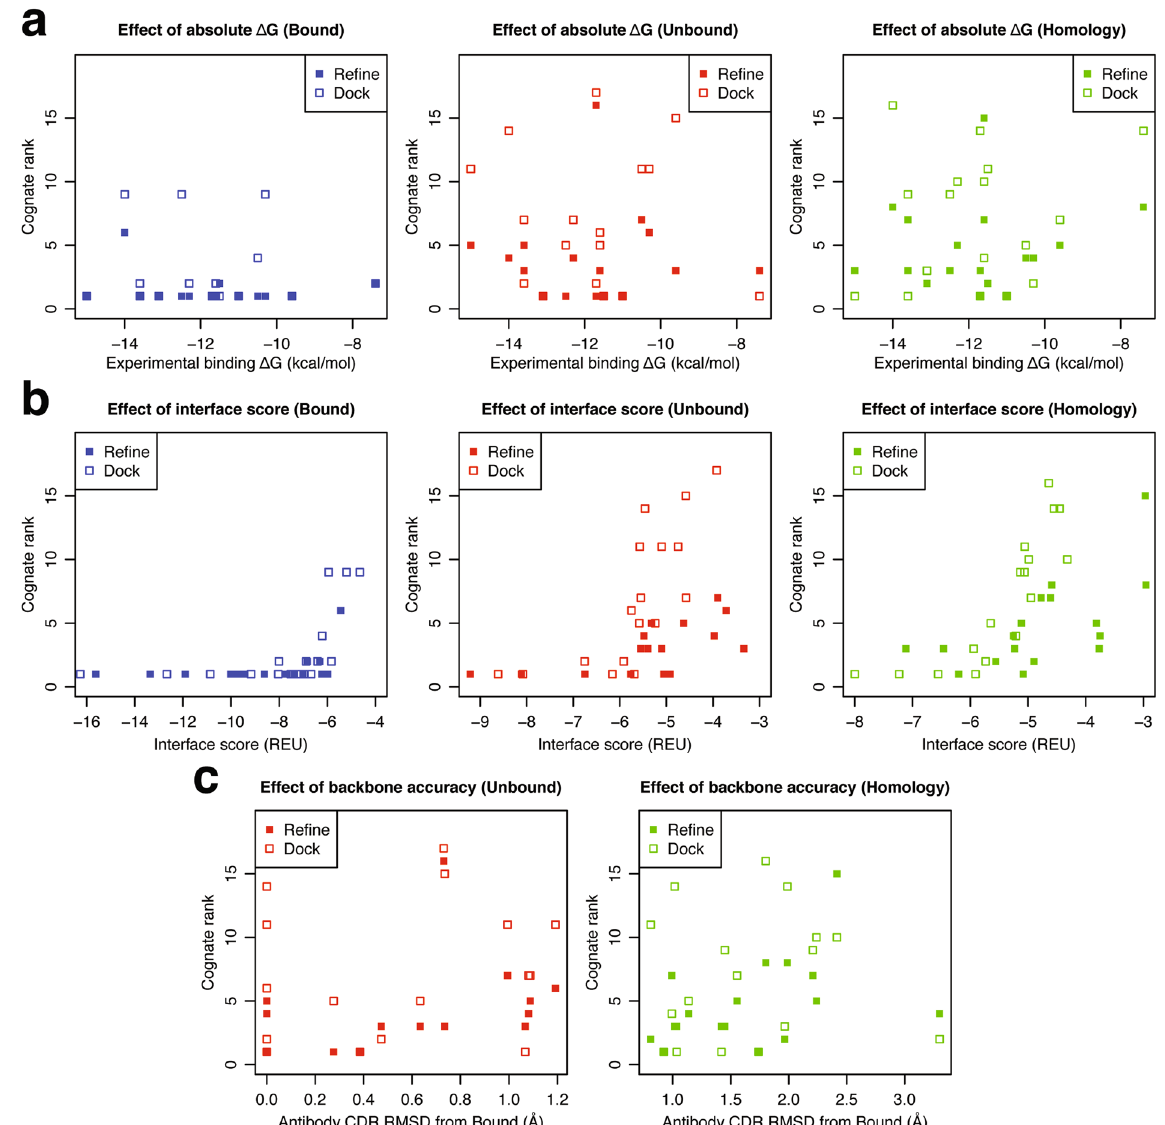
Figure 7. Effects of experimental binding affinities, interface scores, and antibody backbone accuracy. Correlation plots comparing ranks of the top-scoring cognate models to ( a ) experimental binding affinities ( Δ G), ( b ) interface scores, and ( c ) antibody CDR backbone accuracy for bound (blue), unbound (red), and homology (green) complexes. Models generated using local refine and local dock are shown as filled and empty squares,